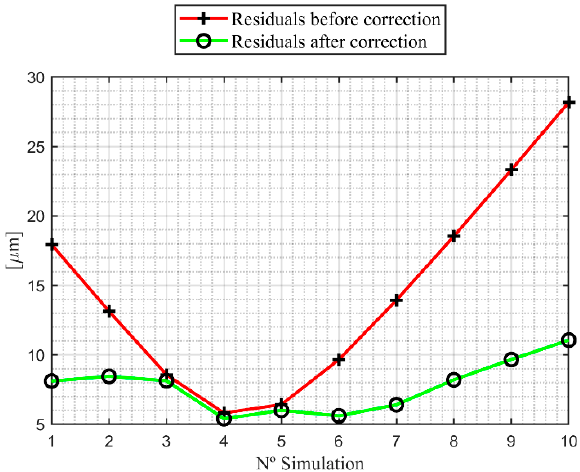
Figure 18. Comparison of the mean residuals before correction and after correction. Electronics 2018 , 7 , x FOR PEER REVIEW